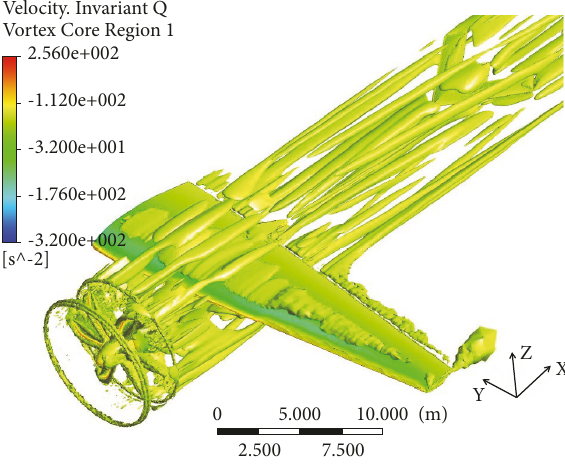
Figure 18: Propeller slipstream effect on the fly wing.